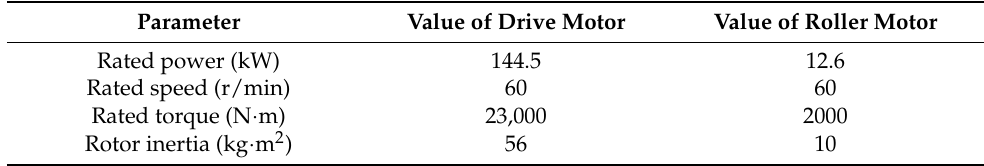
Table 1. Motor Table 1. Motor parameters.